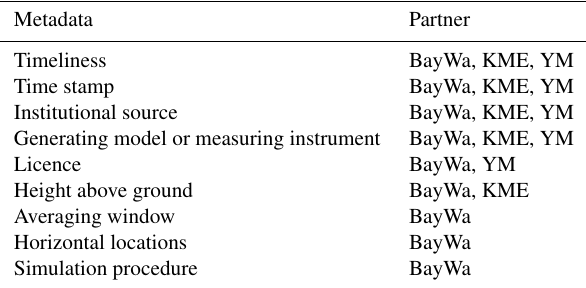
Table 3. Required